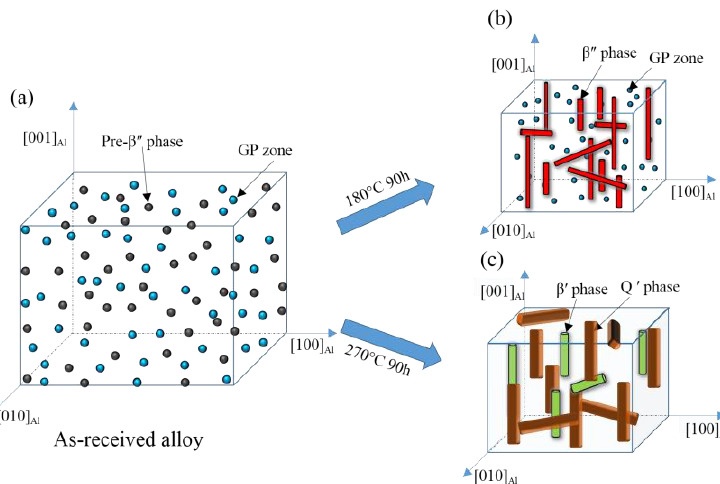
Figure 9. Schematic showing the microstructure of AlSi10Mg(Cu) alloy in different conditions: ( a ) as-received alloy; ( b ) exposed at 180 °C for 90 h; ( c ) exposed at 270 °C for 90 h.